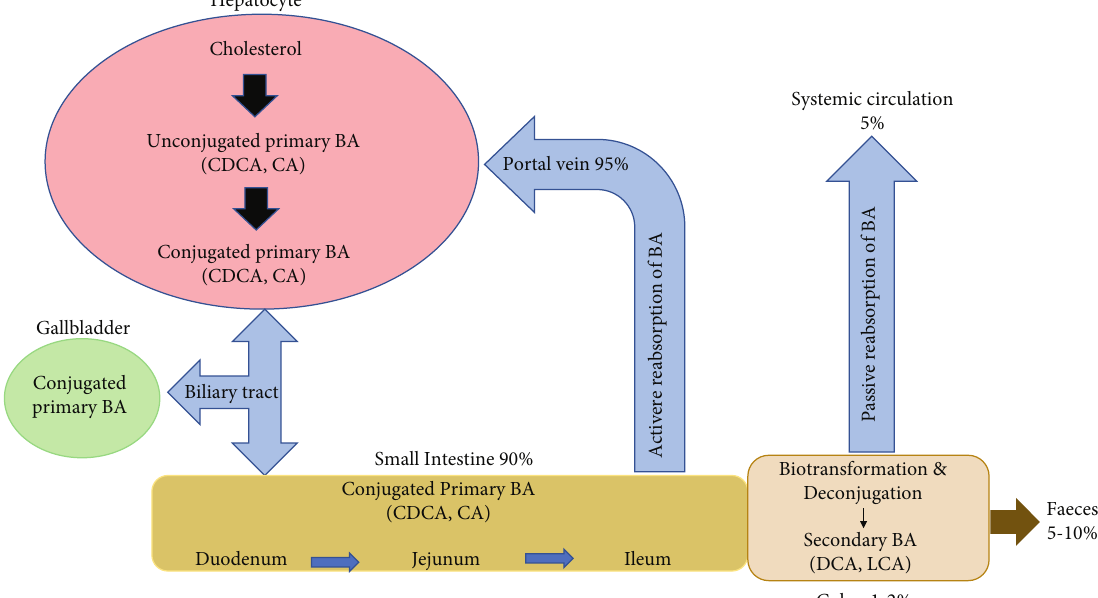
Figure 2: The enterohepatic circulation of bile acids (BA). Primary BA are synthesised from cholesterol in the liver and subsequently conjugated to taurine or glycine, which increases their solubility. The conjugated primary BA are then stored in the gallbladder until they are released into the small intestine by the hormone cholecystokinin (CCK) after a meal. BAs will travel through the small intestine aiding in the digestion and absorption of lipids and fat-soluble vitamins. They will be actively reabsorbed in the ileum where they will return to the liver via the portal vein. A small proportion of BAs will escape intestinal reabsorption and enter the colon. In the colon, the resident gut microbiota will promote the deconjugation and biotransformation of the primary BAs into the secondary and more hydrophilic BAs, deoxycholic acid (DCA) and lithocholic acid (LCA). The majority of secondary BA will re-enter the systemic circulation via passive reabsorption, and a small amount (5%) will be excreted in the faeces.